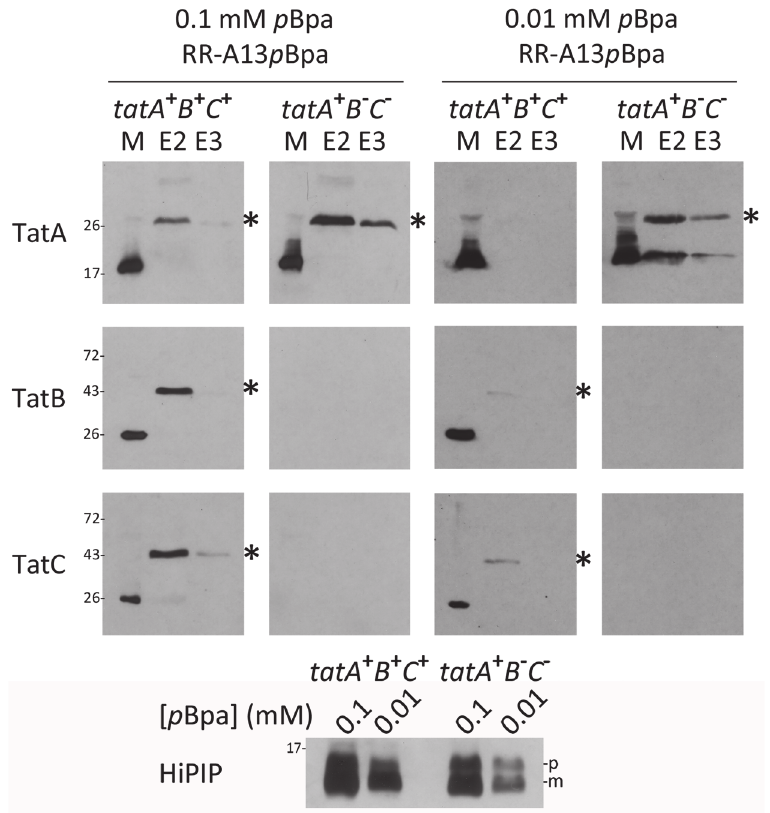
Fig 2. The TatA/Tat signal peptide contact does not require the TatBC components. Comparison of HiPIP-TatA cross-links in the presence/absence of TatBC using p Bpa at position A13. Two p Bpa concentrations (0.1 mM and 0.01 mM) in the growth medium were used to analyze effects of lowered HiPIP concentration. tatA + B + C + : BW25113/pRK- tatABC /pEvol-pBpF /pEXH5 tac -H6-A13 p Bpa; tatA + B - C - : JBdBC/ pRK- tatA /pEvol-pBpF /pEXH5 tac -H6-A13 p Bpa. The bottom blot monitors the decrease of HiPIP levels by reduction of p Bpa concentration in the medium. HiPIP detection in crude extracts. Significant HiPIP degradation to mature size is due to unspecific proteolysis of the signal peptide. See Fig. 1 for further